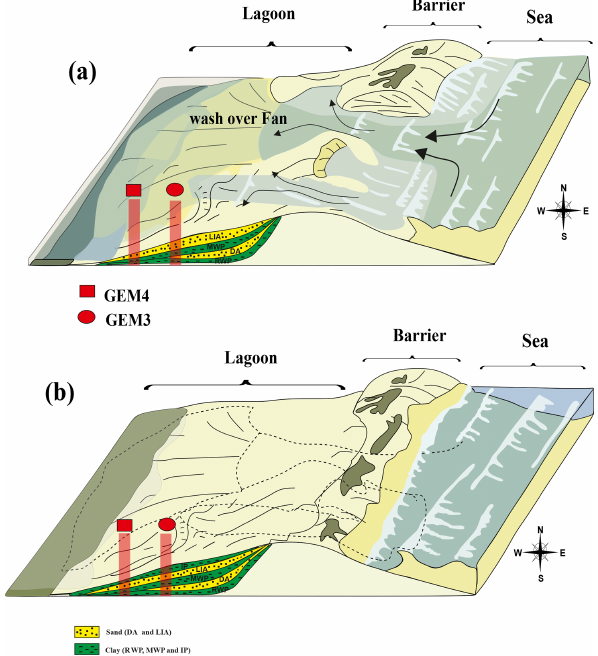
Figure 10. Three-dimensional diagram of the Ghar El Meleh la- goon evolution. (a) Opening of the sandy lido and deposition of the washover in the lagoonal sediment. (b) Reclosure of the